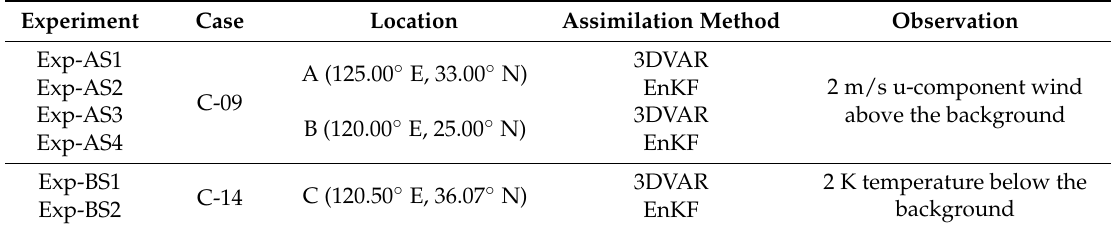
Table 6. Description of single observation tests.